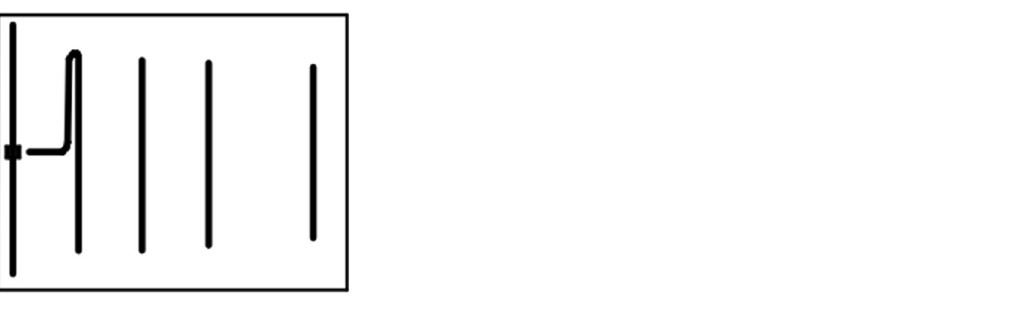
Figure 15. Yagi-Uda antenna